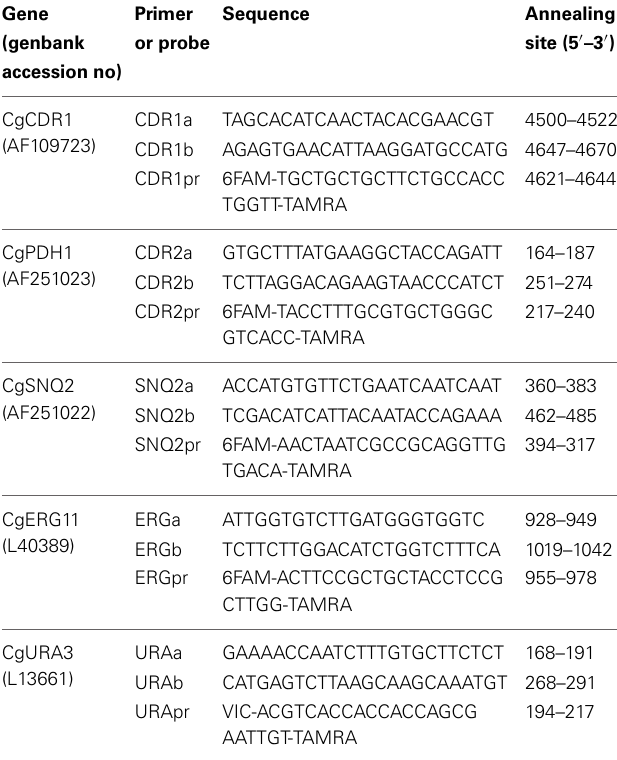
Table 1 | Primers and probes used to amplify CgCDR1 ,